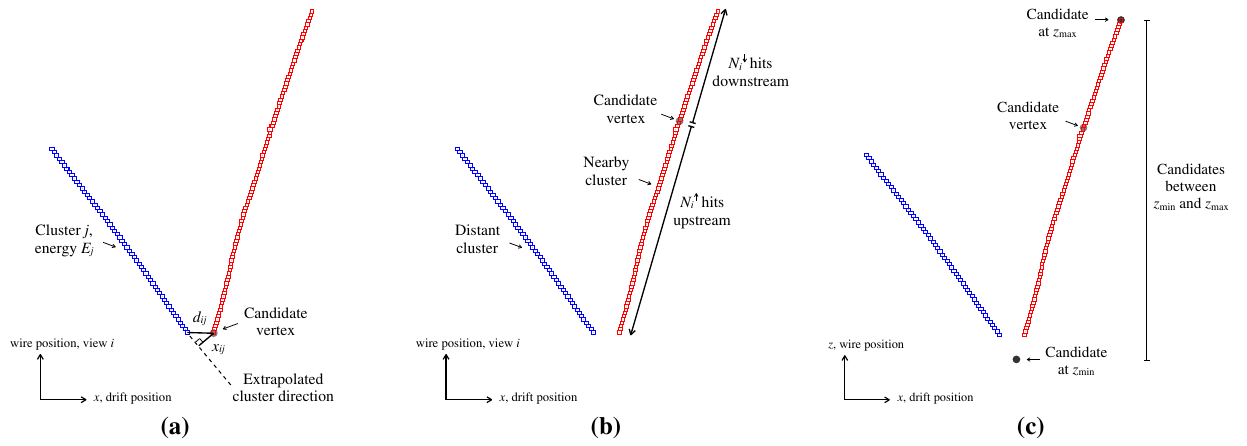
Fig. 6 Illustration of the quantities used to assign a score to candidate vertexpositions: a theenergykickcomponent, b theasymmetrycompo- nent and c the beam deweighting component. Clusters in the w view are shown, alongside the projections of vertex candidates of specific inter-